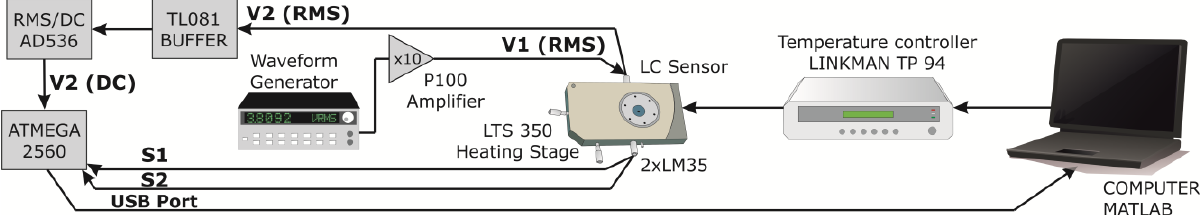
Figure 3. Experimental set-up for characterization of the LC temperature